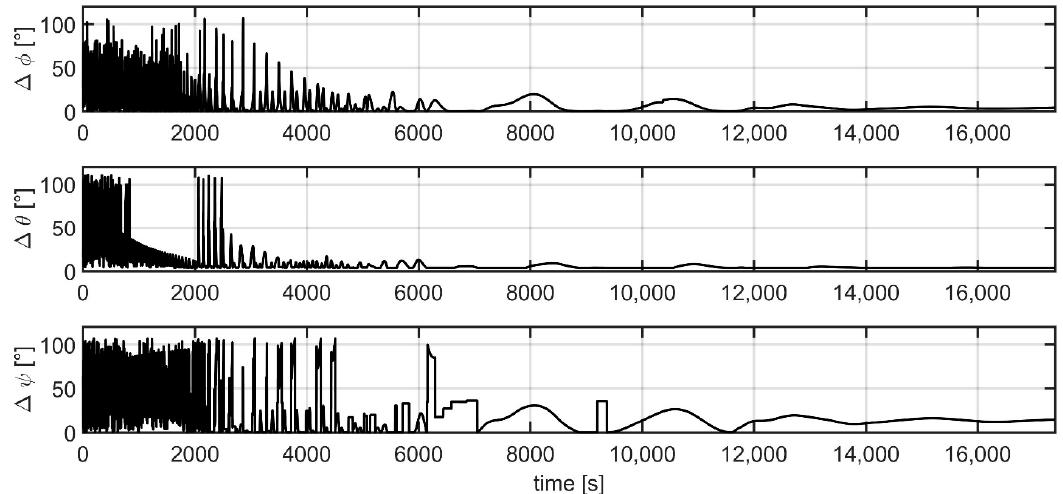
Figure 2. Di ff erence between the actual and estimated Euler angles for Test Case Figure 2. Difference between the actual and estimated Euler angles for Test Case 1.